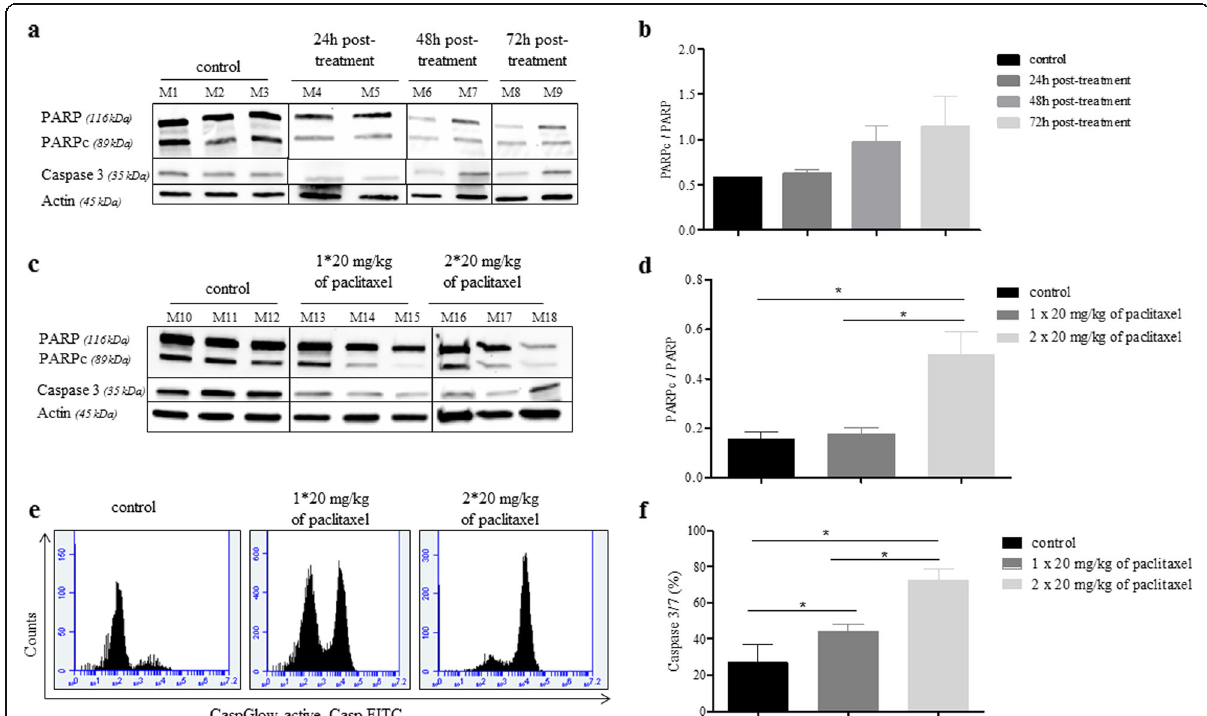
Fig. 4 Characterization of apoptotic tumor after treatment by paclitaxel in MDA-MB-468 subcutaneously xenograft model. a – c Western blot analysis showing the cleavage of PARP and Caspase 3 on tumors samples. Actin was used as a loading control. Individual bands (M1, M2, M3) correspond to 2 – 3 independent tumor samples per group of treatment. b – d Quantification of cleaved PARP as a ratio to PARP. Data are presented as the mean ± SD. Mann-Whitney test was performed (* p < 0.05). Significant difference versus control group. e Increase of cleaved caspase 3-positive tumor cells was observed after paclitaxel treatment. f Quantitative analysis of apoptotic cells measured by flow cytometry in control or paclitaxel treated. Data are presented as the mean ± SD. Compared to control, *** p <